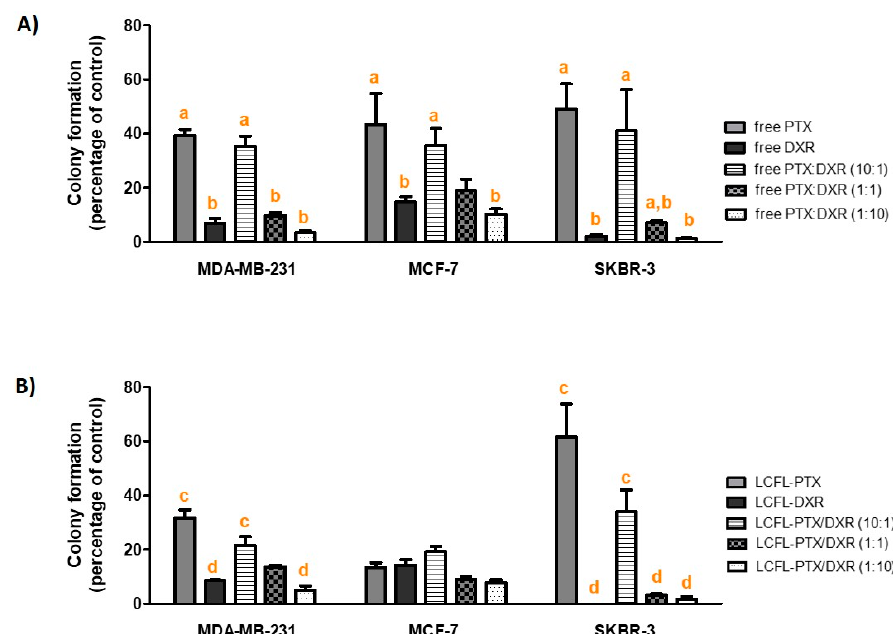
Figure 6. Percentage of colony formation in relation to the control for the different cell lines evaluated when exposed to different ratios of free ( A ) or liposome co-encapsulated PTX and DXR ( B ) at total concentration of 70 nM for 48 h. Data for MDA-MB-231 and MCF-7 cell lines were transformed as y = log(value) and for SKBR-3 cell line as y = log(value + 1) prior to ANOVA. a differs statistically from free DXR treatment; b differs statistically from free PTX treatment; c differs statistically from LCFL-DXR treatment; d differs statistically from LCFL-PTX treatment. Ratio in parenthesis refers to PTX:DXR molar ratio. Abbreviations: DXR, doxorubicin; PTX, paclitaxel; LCFL, long-circulating and fusogenic liposomes; LFCP-PTX/DXR, long- circulating and fusogenic liposomes co-encapsulating paclitaxel and doxorubicin.